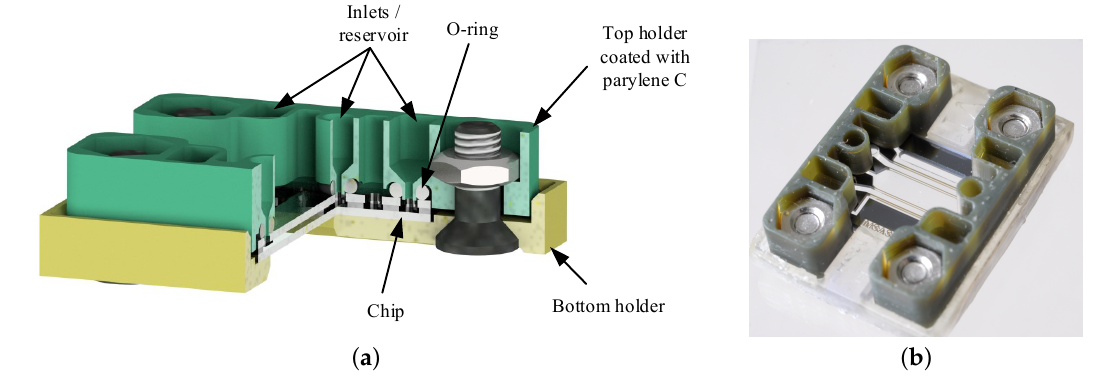
Figure 6. Assembly of the microfluidic chip that is clamped between 3D-printed holders and sealed with O-rings: ( a ) model of the assembly showing all components ( b ) image of the assembly with the dimensions of 29 × 21.7 × 7.9mm.